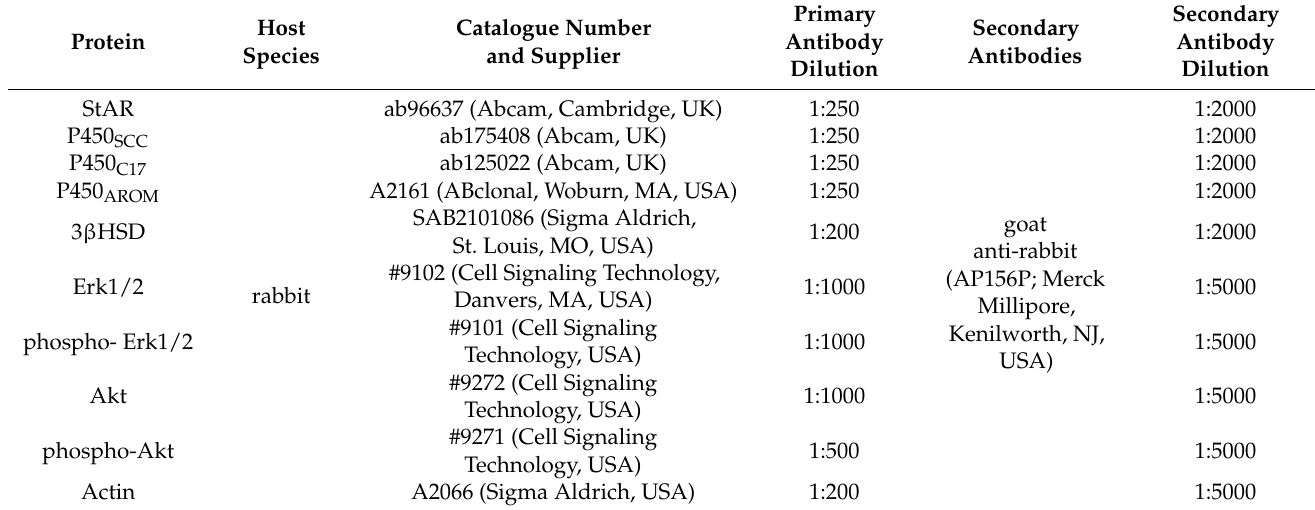
Table 1. Specifications of antibodies used for the Western blot